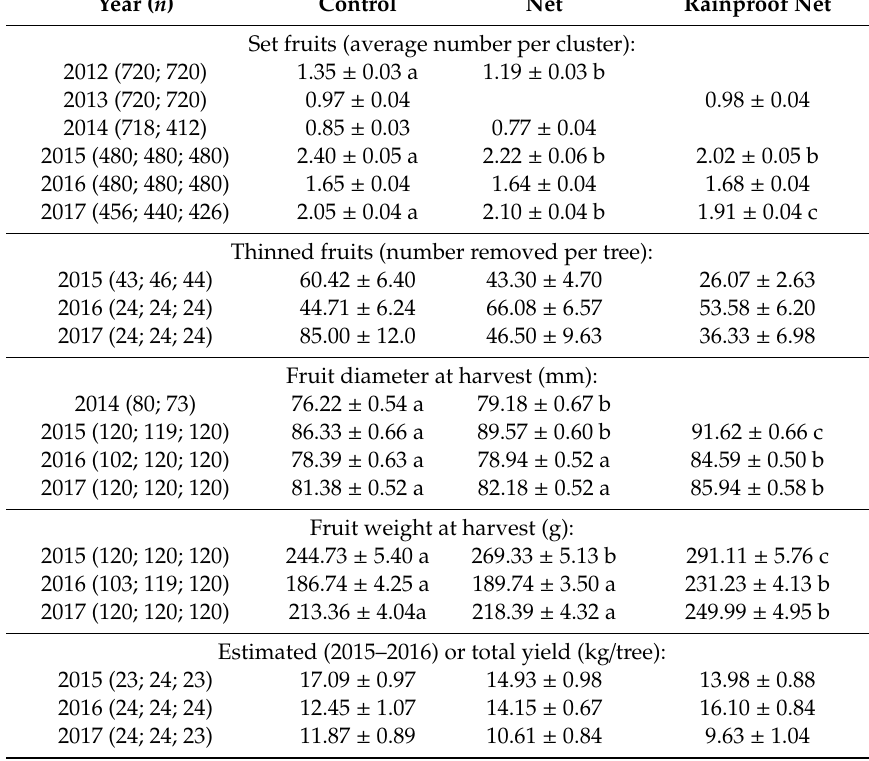
Table 4. Fruit load and yield measurements (number at fruit set, number removed during thinning operations, weight and size at harvest and weight per tree at harvest) (mean ± SE, n = total number of observations) for fruits harvested from row units without nets, with nets and with rainproof nets. Di ff erent letters indicate statistically significant di ff erences between treatments for appropriate years (Tukey tests except for nonparametrical “set fruits” which required a Dunn test + Bonferroni correction, p <